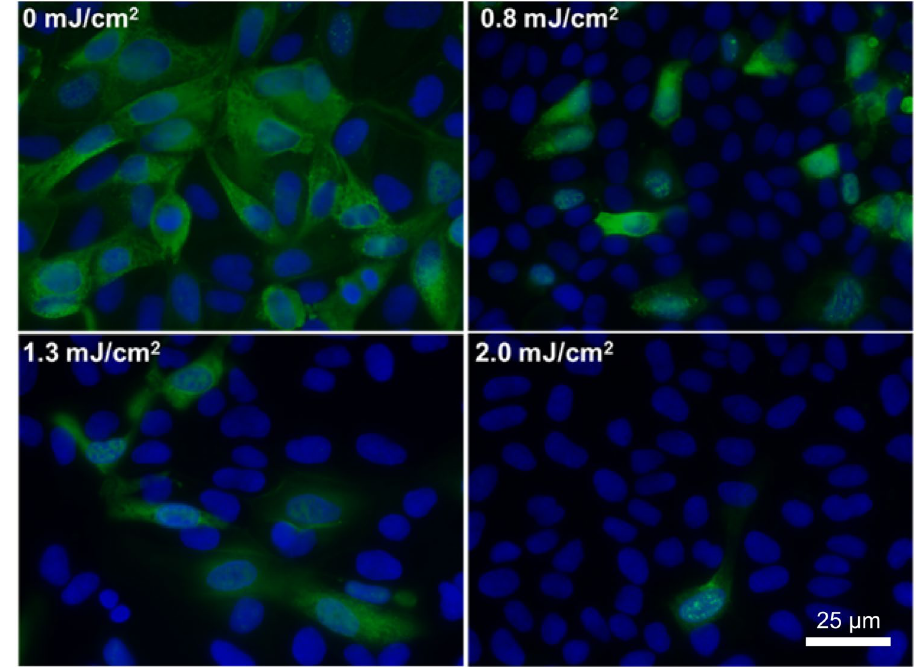
Figure 1. Antiviral efficacy of different low doses of 222-nm far-UVC light. Typical fluorescent images of MDCK epithelial cells infected with influenza A virus (H1N1). The viruses were exposed in aerosolized form in the irradiation chamber to doses of 0, 0.8, 1.3 or 2.0 mJ/cm 2 of 222-nm far-UVC light. Infected cells fluoresce green (blue = nuclear stain DAPI; green = Alexa Fluor-488 conjugated to anti-influenza A antibody). Images were acquired with a 40 × objective.